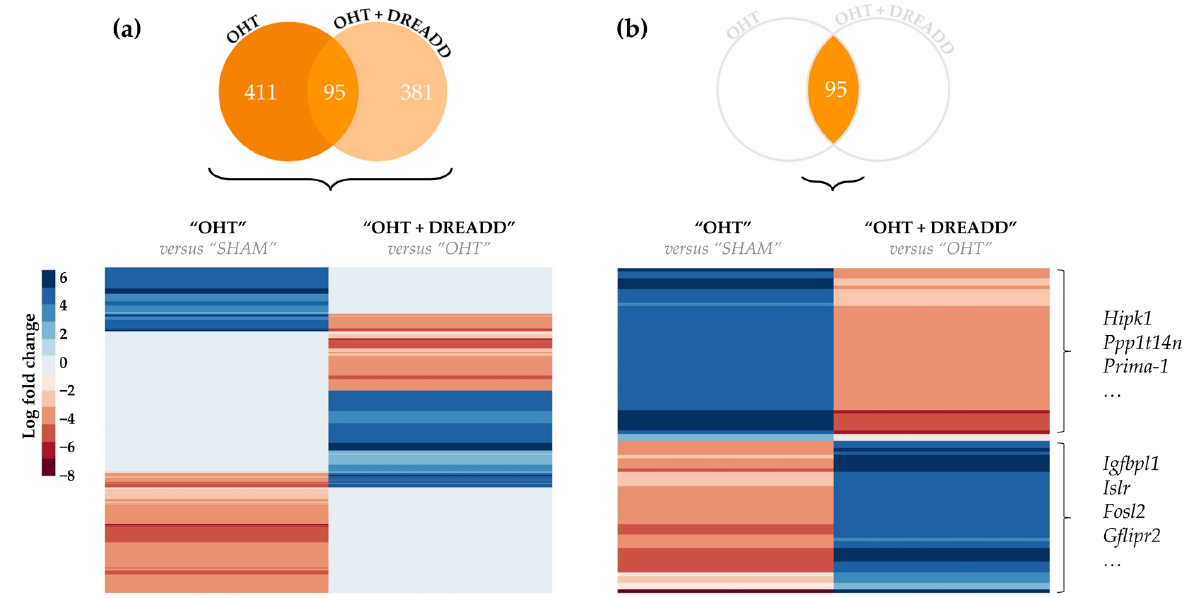
Figure 7. Heatmaps of the differentially expressed genes (DEGs) detected in the “OHT” vs. “SHAM” and “OHT + DREADD” vs. “OHT” comparisons of the RGC transcriptome. ( a ) Comparing the gene expression of all DEGs—i.e., unique and shared DEGs between both datasets—showed that chronic target stimulation partially reversed the disease signature. ( b ) This reversal of disease signature is emphasized when only plotting the shared DEGs. Red and blue colors denote a decreased (log fold change < − 1.3) and increased (log fold change > 1.3) gene expression, respectively, whereas a white color represents genes that were not differentially expressed.